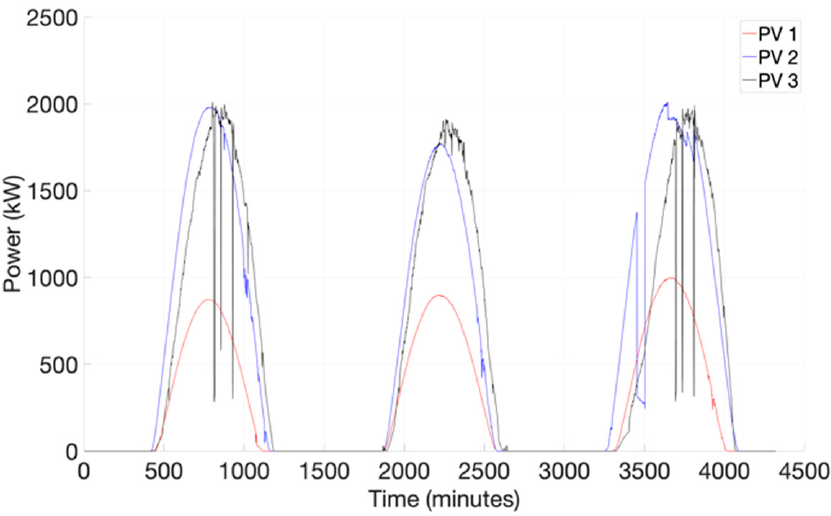
Figure 4. Photovoltaic power generation.